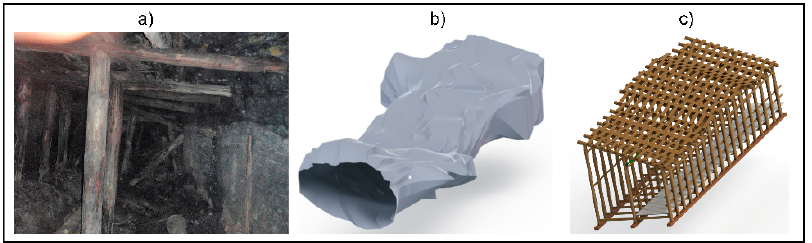
Figure 7. View of the underground working with parts of a loosened wooden casing ( a ), outline of the scanned area of the working ( b ) and designed new underground working support ( c )